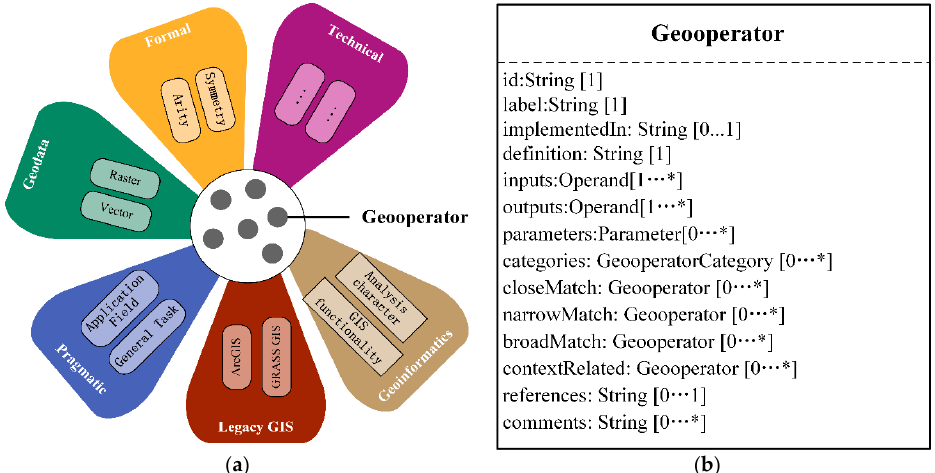
Figure 3. ( a ) Different perspectives on Geooperator [41] ( b ) Description elements of Geooperator [17].